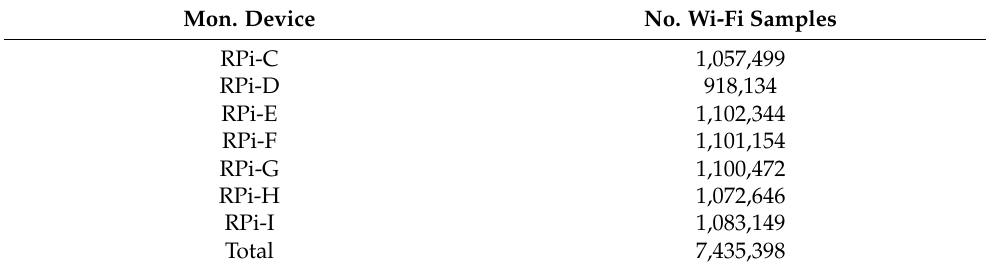
Table 1. Number of collected Wi-Fi samples for each Monitoring Device. Mon.